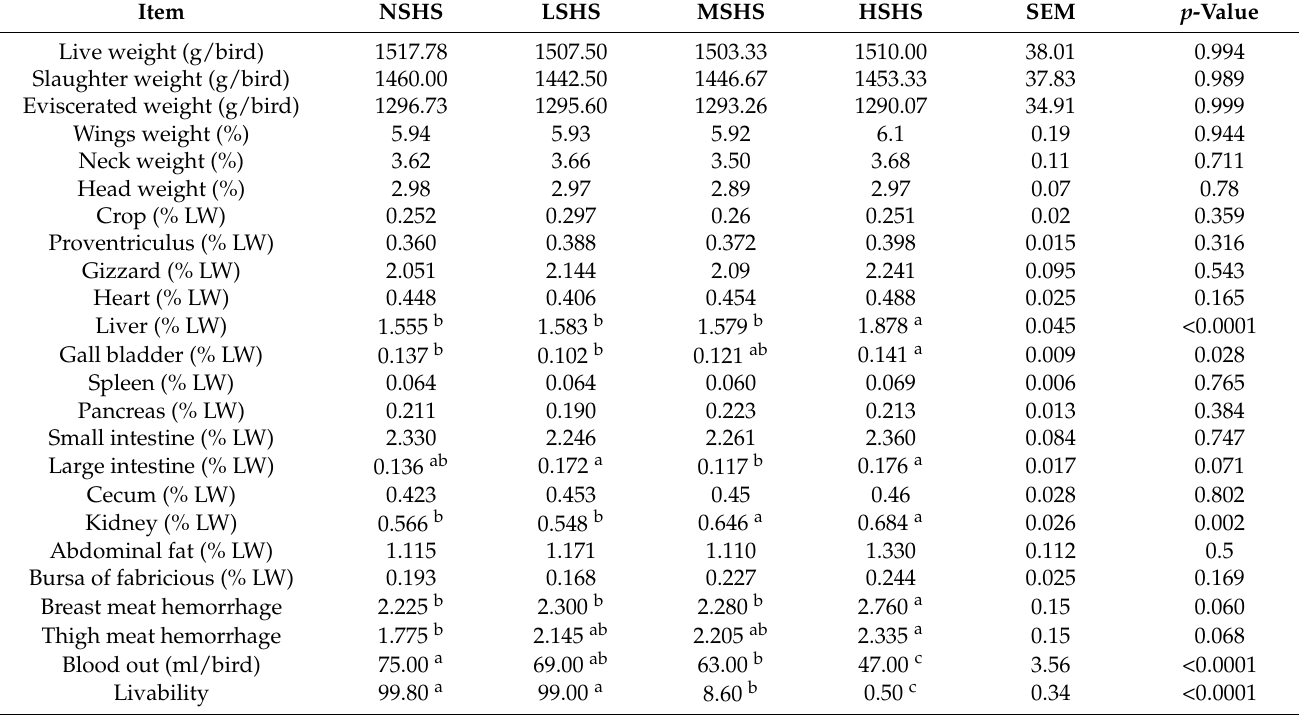
Table 1. Effects of the level of electrical stunning, halal neck cutting, and subsequent bleeding on the carcass characteristics, livability, and bleeding out in broiler